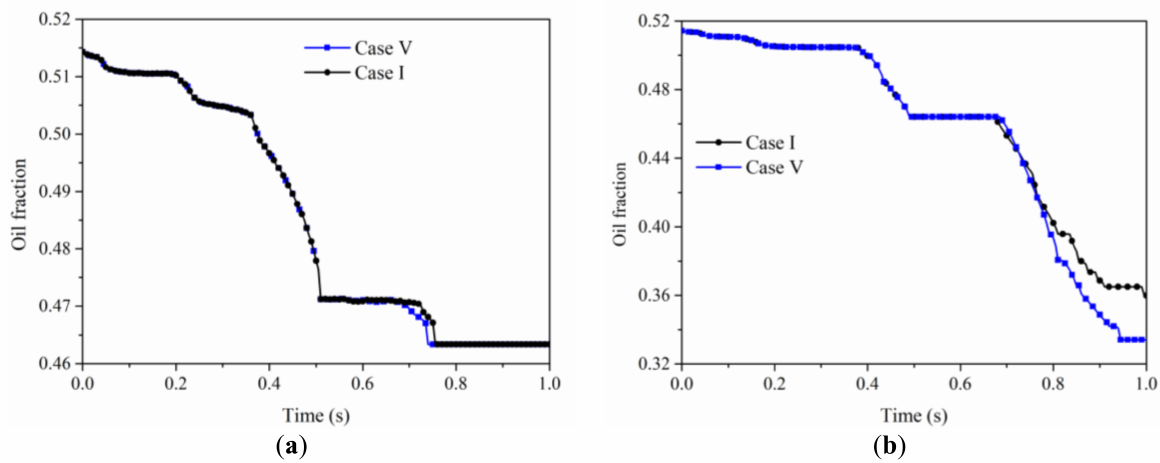
Figure 17. Oil saturation variation with time in continuous injection and slug injection ( a ) small particles ( b ) large